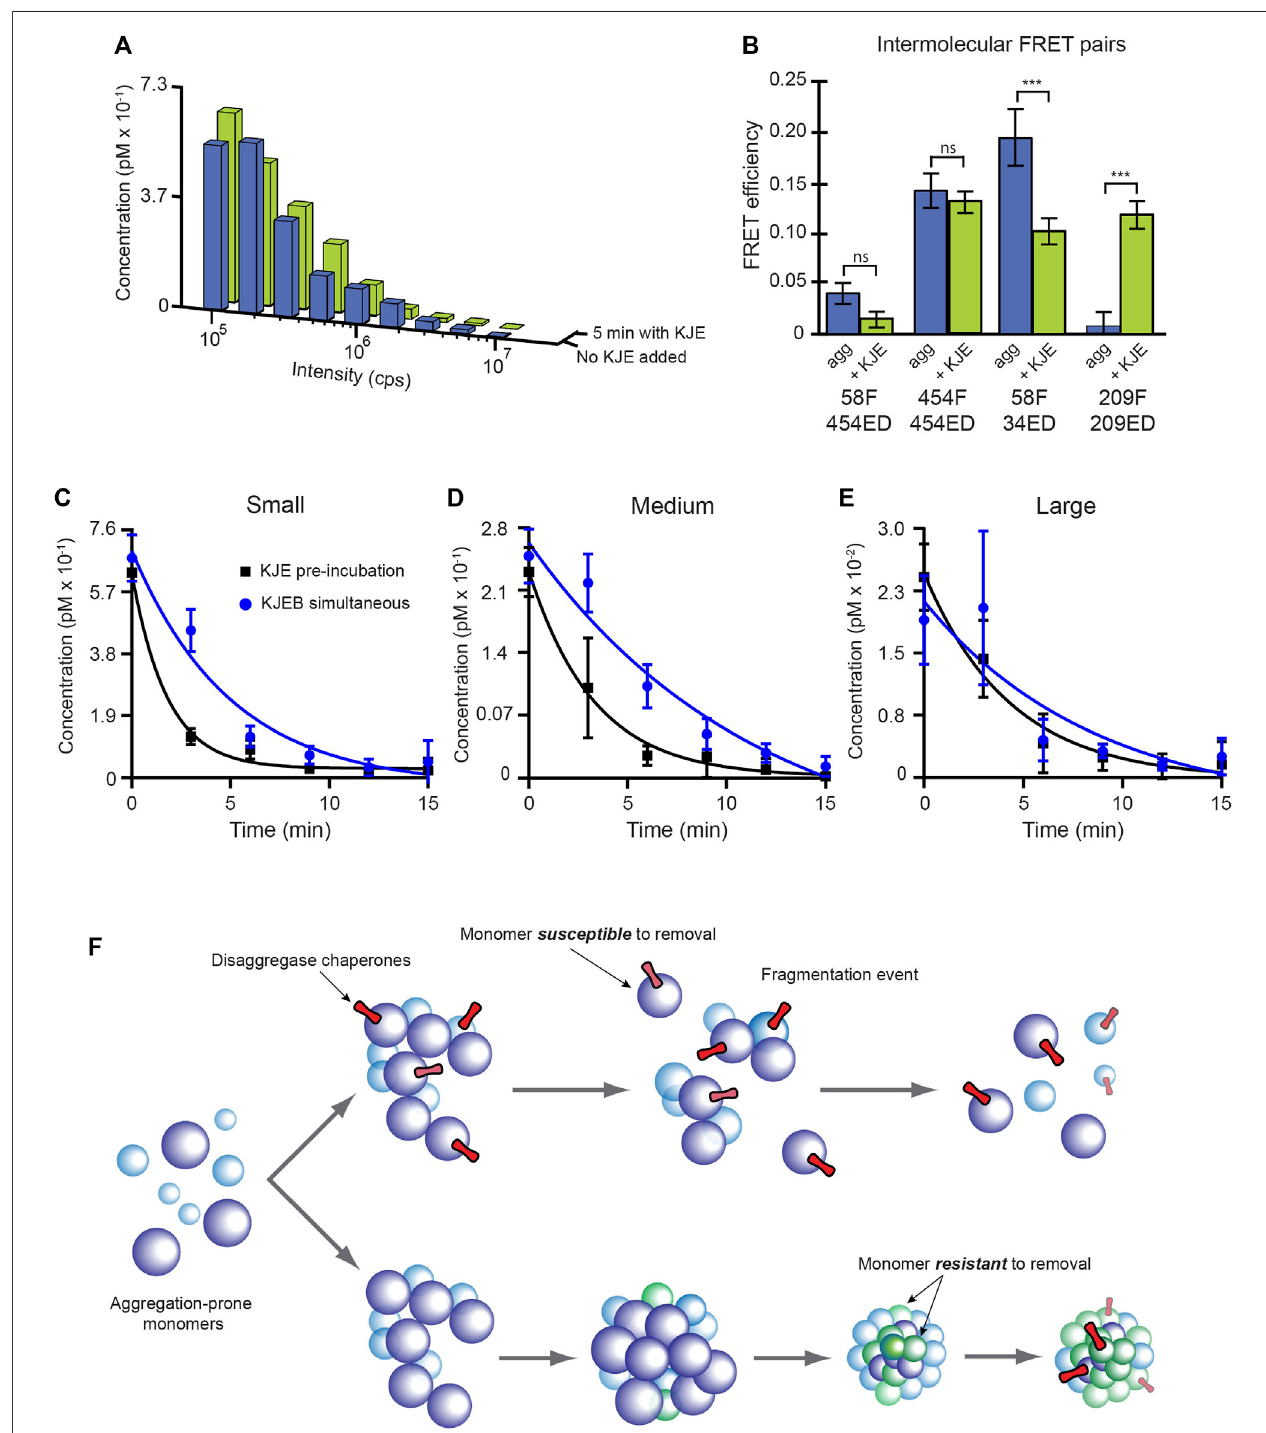
FIGURE 8 | The KJE system enhances ClpB-mediated disaggregation by altering aggregate structure. (A) S-type RuBisCO-TMR aggregates grown for 3.5 min wereincubated for5 mineitherwithout(blue)orwith(green)theKJEsystemalone(100 nMDnaK,200 nMDnaJ,and200 nMGrpEand2 mMATP).Theaggregatesize distribution observed for each sample, from a standard BAS measurement, is shown. (B) The average conformational properties of S-type aggregates were examined with sensitized intermolecular FRET after a 5 min incubation either with or without the KJE system. Co-labeled S-type aggregates (1:1 donor-to acceptor-labeled monomers at 1:4 total labeled to unlabeled monomers; 58F + 454ED) were grown for 3.5 min and then incubated for 5 min either with or without the KJE system alone, as described in panel (A) . Error bars show the standard deviation of n = 3 independent experiments and student ’ s t-test p -values of *** < 0.005. (C,D) Brief pre-